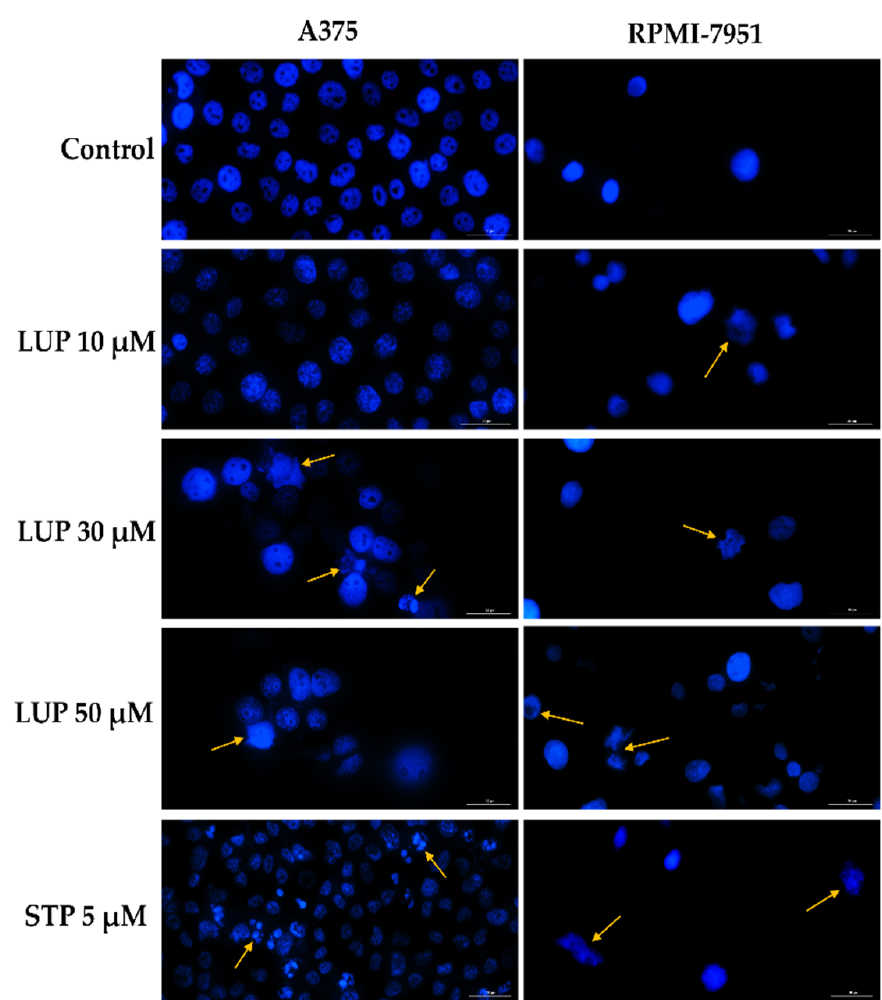
Figure 3. Cell nuclei staining using Hoechst 33342 in A375 and RPMI-7951 malignant melanoma cells following the 24 h treatment with LUP 10, 30, and 50 µ M. Staurosporine (STP) 5 µ M was selected as positive control for apoptosis. The arrows indicate apoptotic nuclei expressing specific features. The scale bars represent 30 µm.